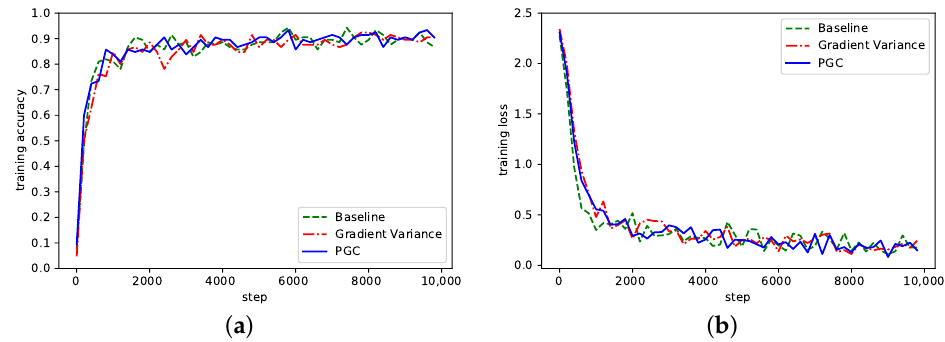
Figure 8. ( a ) Accuracy in ResNet network on Cifar10; ( b ) Loss curve in ResNet network on Cifar10. It can be seen from Figures 7 and 8 that the PGC method in this paper also achieved better accuracy and convergence effect on different datasets. To sum up, by analyzing the convergence of the algorithm on the three network models, the algorithm proposed in this paper could achieve good convergence under the same experimental conditions. At the same time, compared with the other two methods, it also achieved better contrast. In this section, the training accuracy of all network models are shown in Table